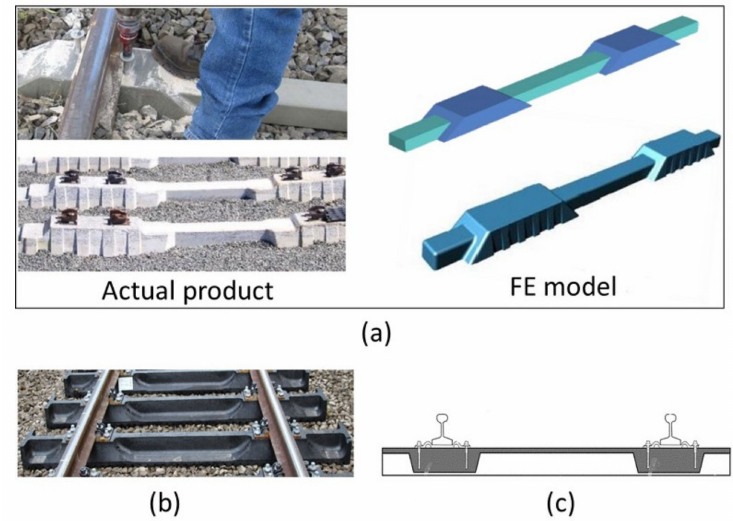
Figure 1. Different shapes of alternative sleepers: ( a ) composite sleepers [28–30], ( b ) recycled plastic sleeper [31] and ( c ) alternative composite sleeper patent